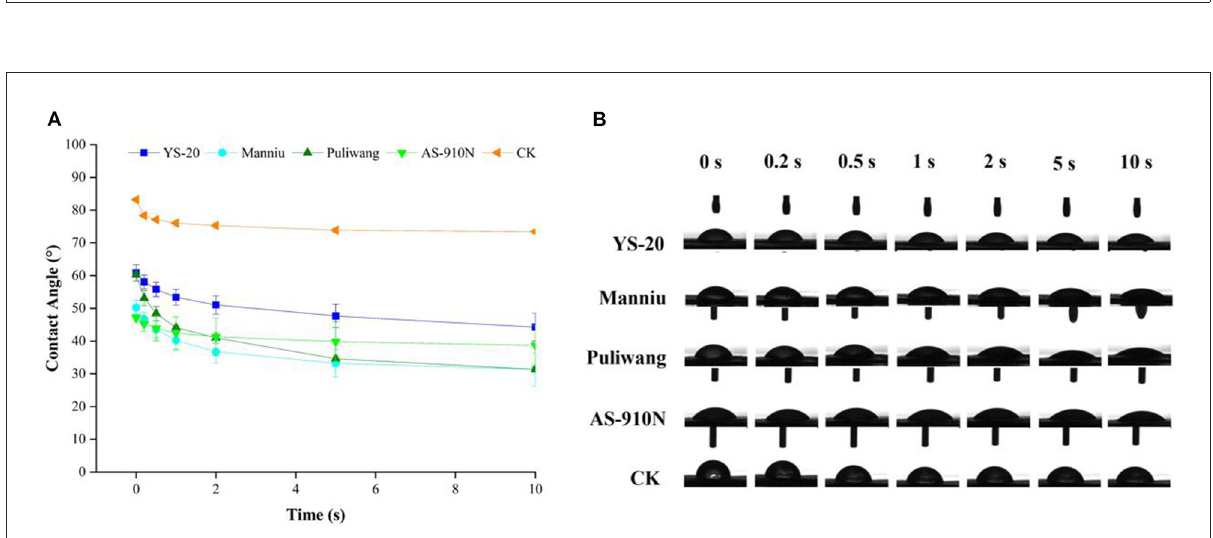
FIGURE3 Effect of aerial spray with adjuvants on contact angle line graph (A) and experimental images (B)